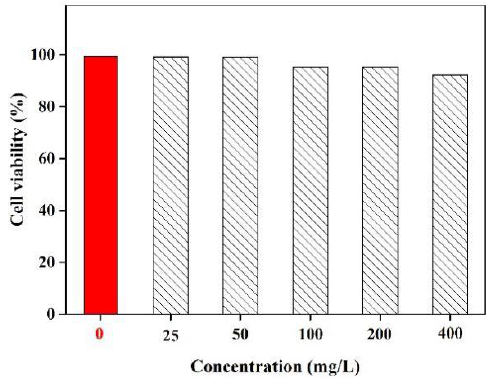
ff erent concentrations of